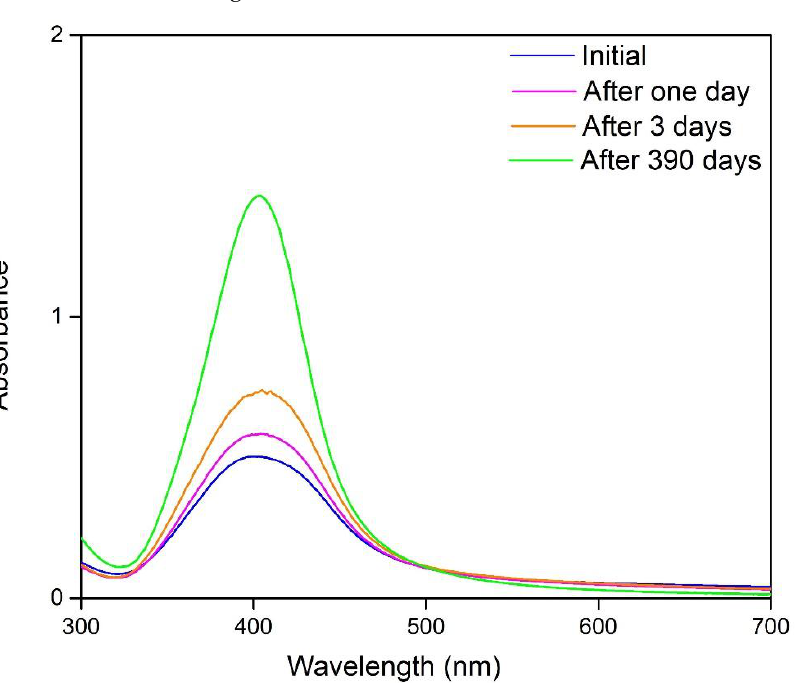
Figure 10. Stability studies. Figure 9. Stability